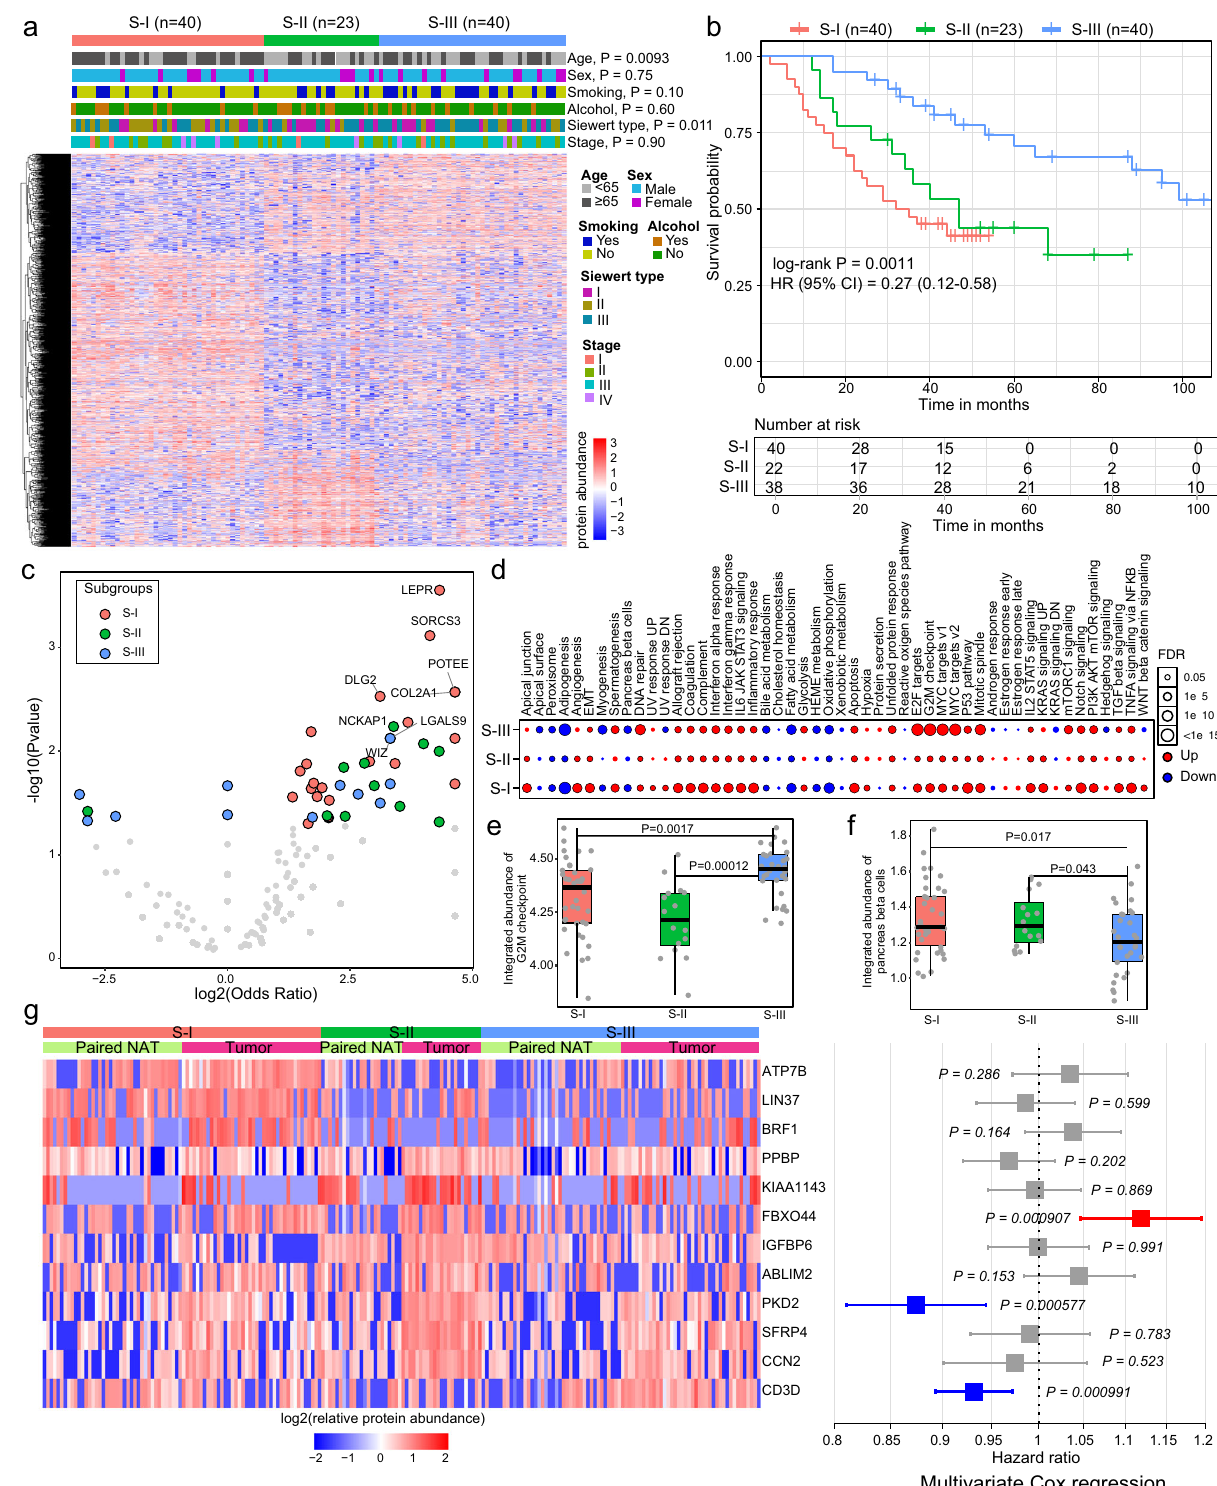
proliferation by 68.1% ( P =0.002) and by 49.1% ( P =0.005) (Fig. 4e and Supplementary Fig. 11c), decreased cell invasion by 79.3% ( P =0.008) and 70.9% ( P =0.001) (Fig. 4f and Supplementary Fig. 11d), and reduced cell migration by 71.8% ( P =0.005) and 54.7% ( P =0.003) (Fig. 4g and SupplementaryFig. 11e) in OE19 and SK-GT-4, respectively. TheoncogenicroleofFBXO44inAEGwasfurthervalidatedintheOE19 xenograft mouse model. We observed that FBXO44 OE increased the growth of AEG xenograft tumors by 2.54-fold ( P = 0.004), whereas